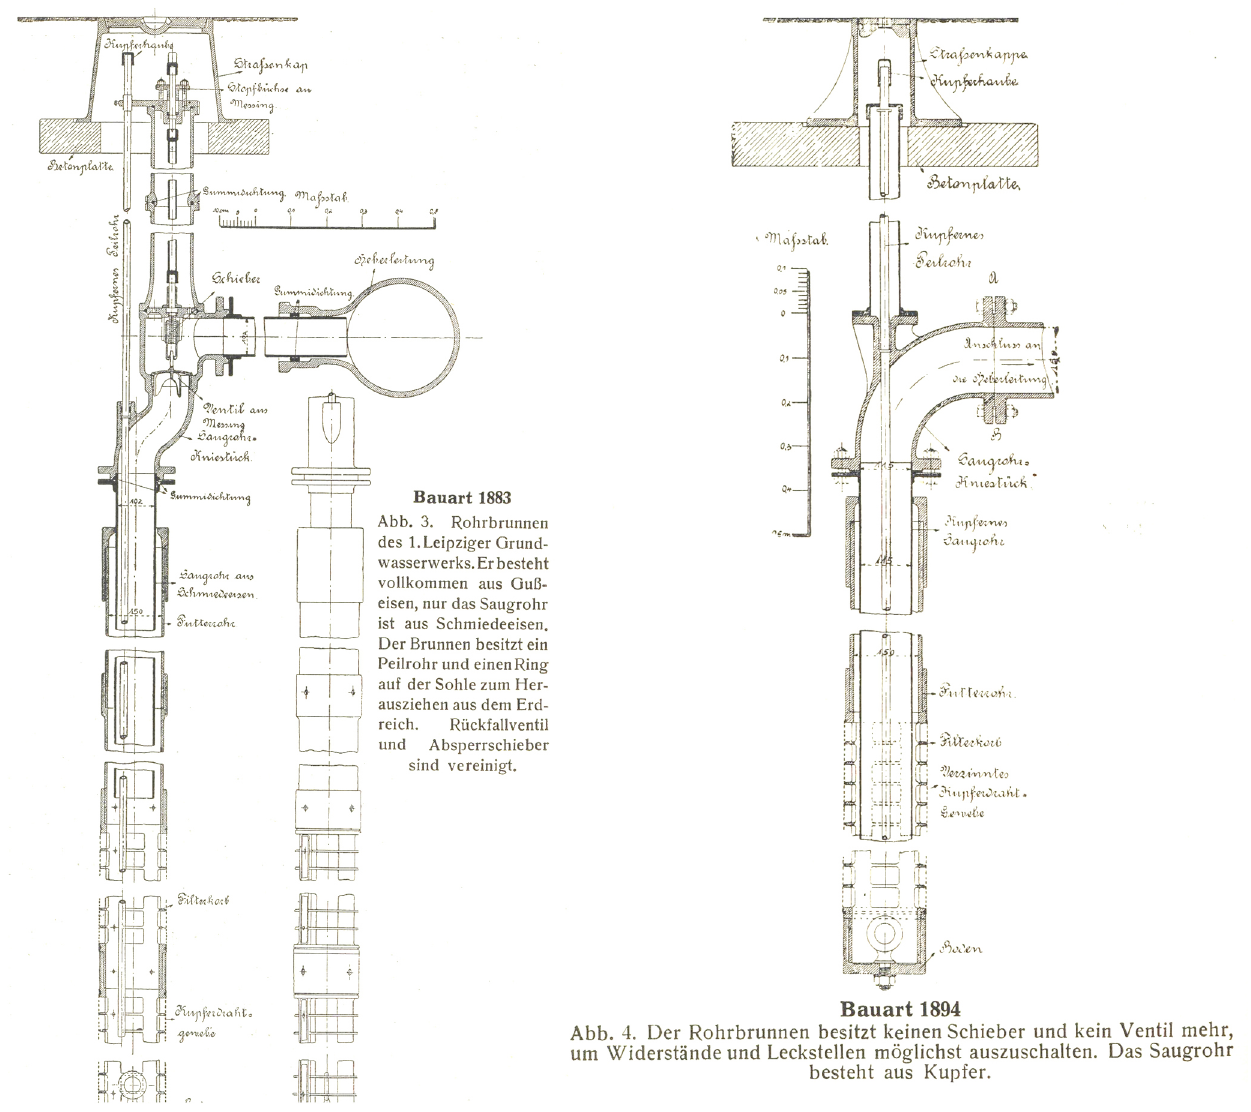
Figure 5. Well designs by Adolf Thiem used in Leipzig. On the left-hand side is the first design from 1883, including a cast iron screen and a riser pipe from wrought iron. On the right-hand side is a simplified design from 1894, with the backflow valve omitted and the suction pipe now made of copper (Thiem,